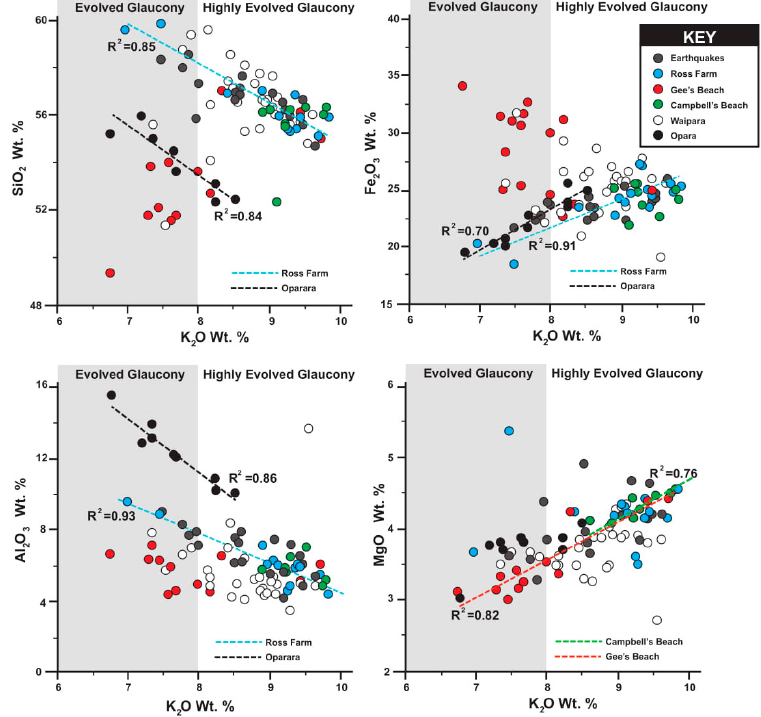
Figure 3. Major element plots showing EDS results for SiO 2 , Fe 2 O 3 , Al 2 O 3 , and MgO plotted against K 2 O. Lines of best fit are plotted for R 2 values > 0.70.